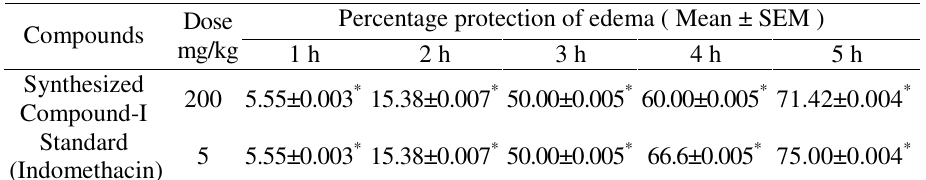
Table 1. Evaluation of anti-inflammatory activity by carrageenan induced hind paw edema in